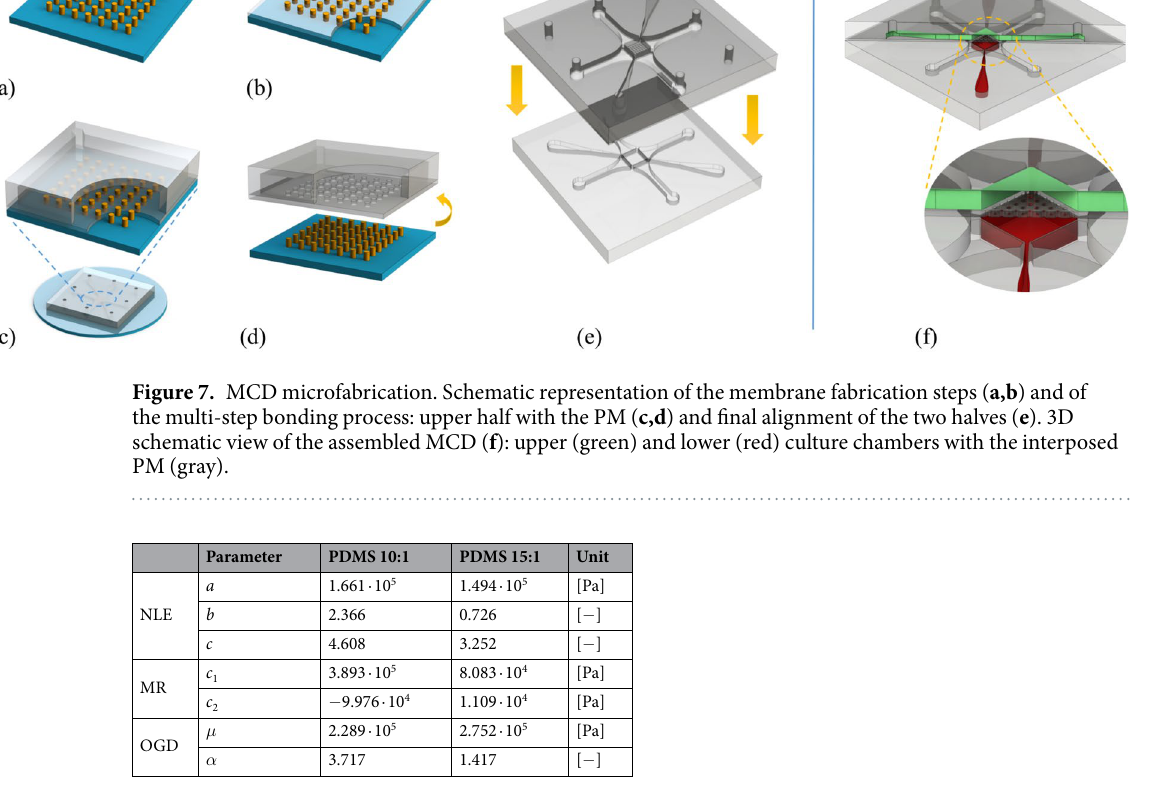
Table 1. Fitting parameters of the three constitutive laws (7), (8), (9) adopted to model PDMS at 10:1 and 15:1 v/v pre-polymer to catalyst ratio. Nonlinear elastic material parameters ( a , b , c ) were obtained via